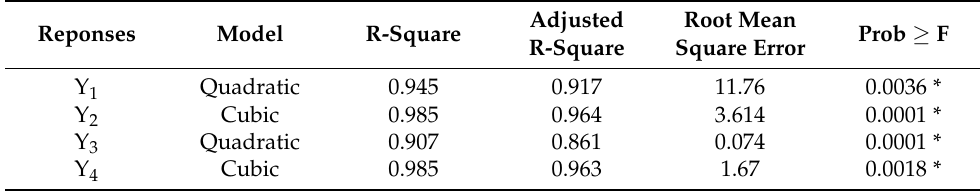
Table 3. Model fitting and statistical analysis.